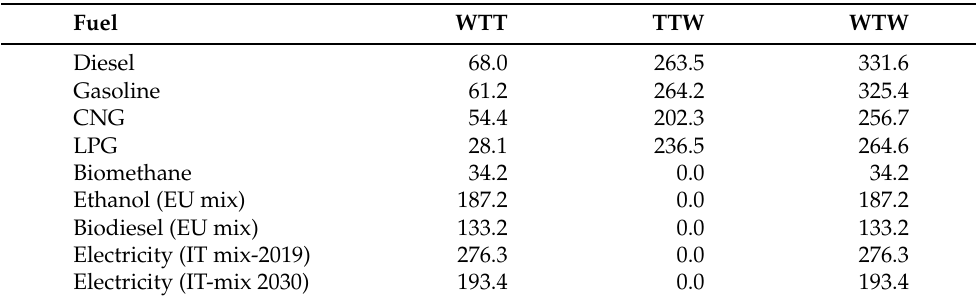
Table 2. Emission factors expressed in g CO2eq /kWh for well-to-tank (WTT), tank-to-wheels (TTW), and well-to-wheels (WTW) analyses for different fuels. Source: [32].